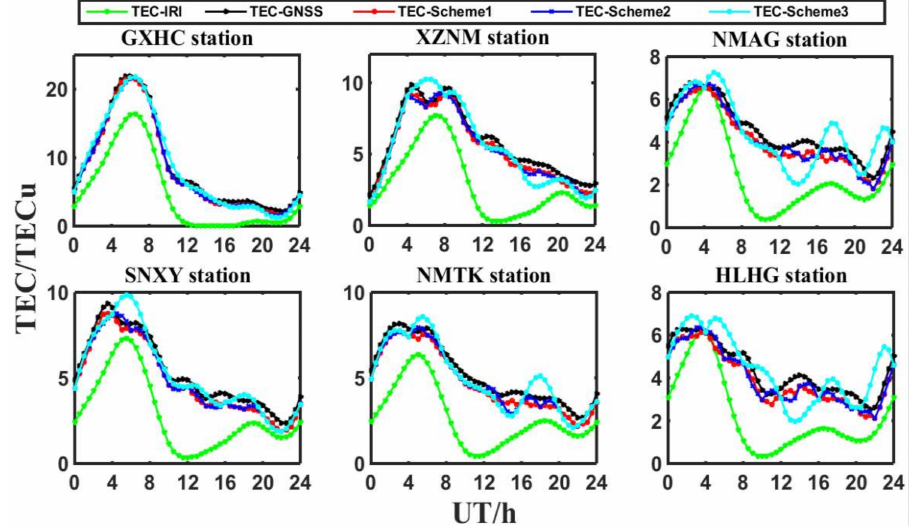
Figure 4. Comparison between TEC estimates corrected using different temporal interpolation schemes and GNSS-TEC at six receiver stations on the first day of